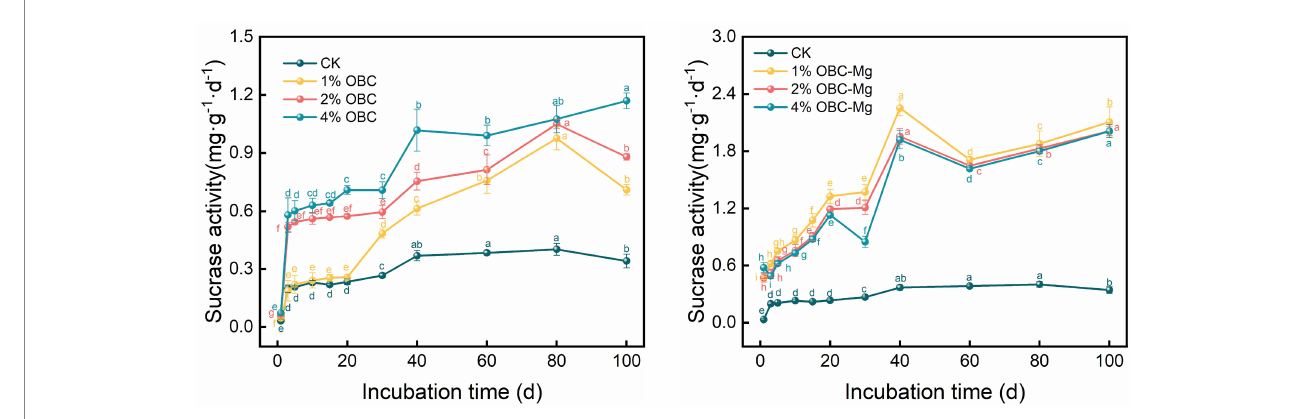
FIGURE 14 Changes in soil sucrase activity after the amendment of OBC and